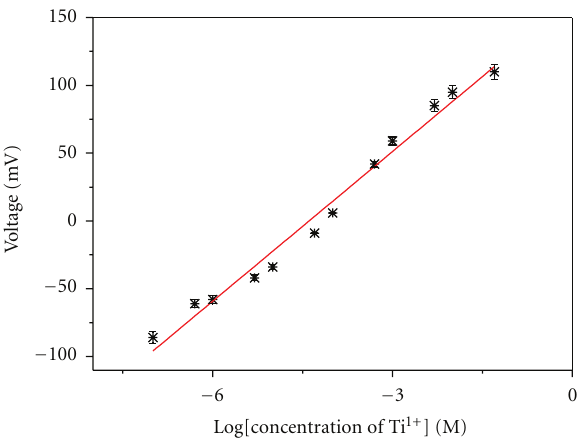
Figure 2: Calibration curve for thallium ion sensor.